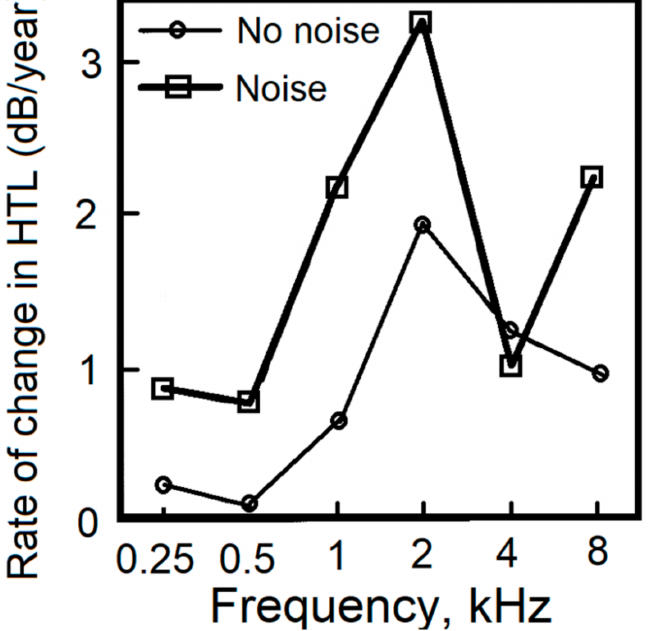
Figure 1. Rate of change of HTLs (dB/year) for groups with high prior noise exposure (thick line with squares) and low prior noise exposure (thin line with circles). Redrawn from Rosenhall